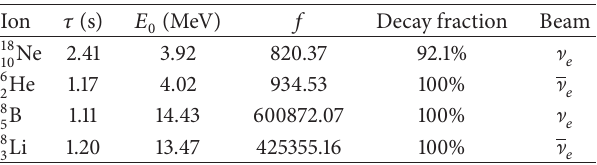
Table 5: Beta decay parameters: lifetime 𝜏 , electron total end-point energy 𝐸 0 , 𝑓 -value, and decay fraction for various ions. This table has been taken from